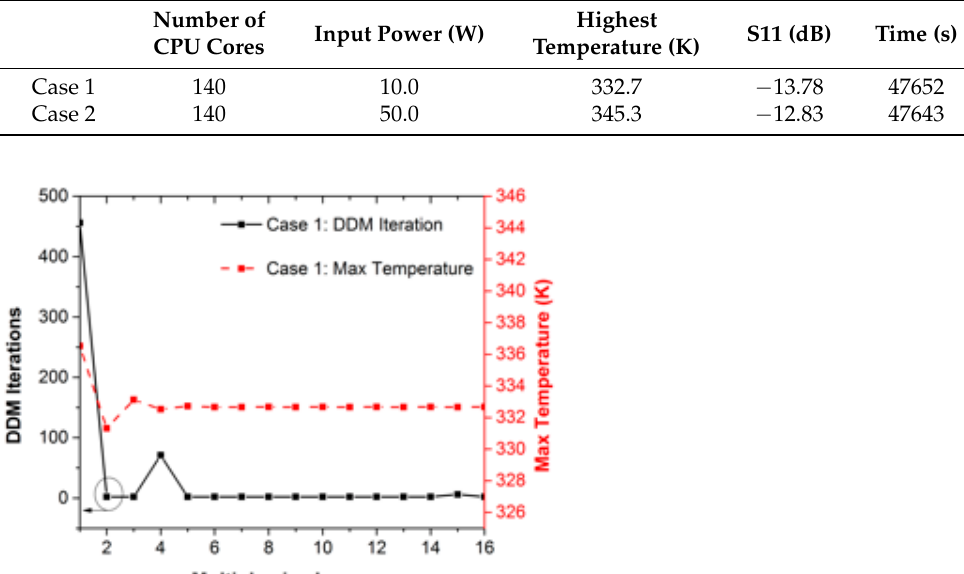
Figure 6. DDM iteration step change and maximum temperature change during multiphysics sim- ulation of case 2. Figure 7. S parameter change during the multiphysics simulations.